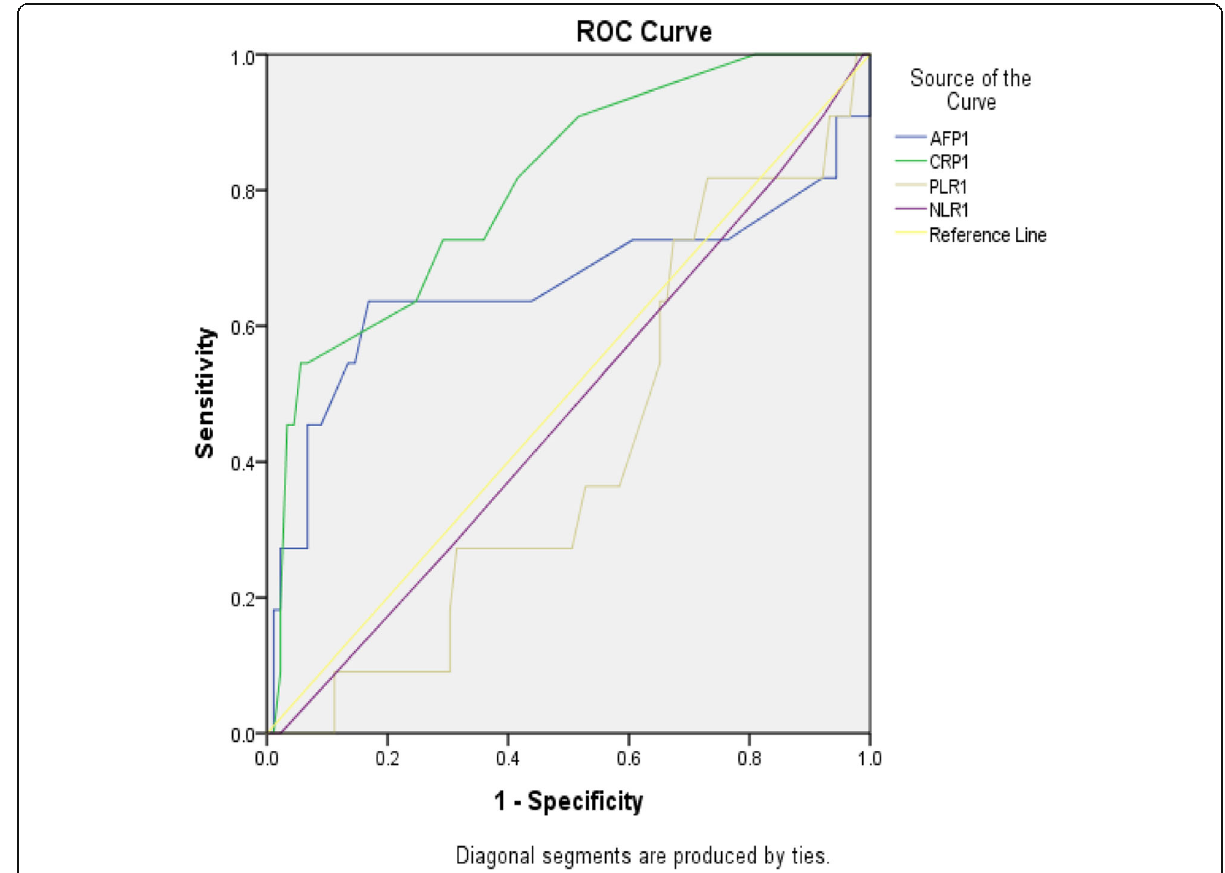
Fig. 3 Predictive ability of post-transplantation AFP, CRP, PLR, and NLR for prediction of HCC recurrence